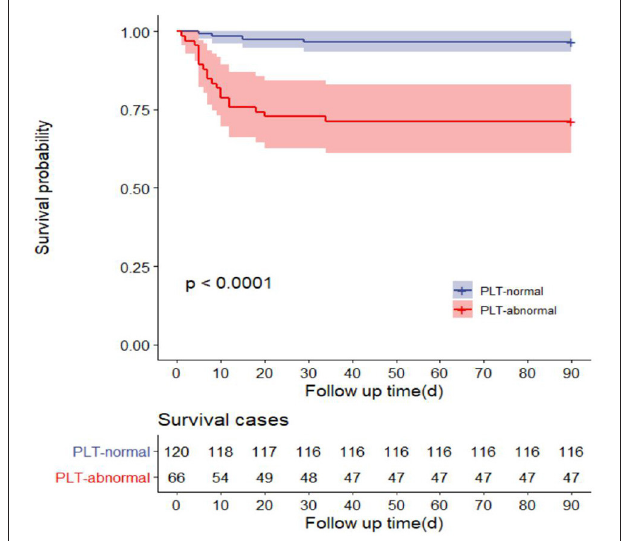
FIGURE 2 | Survival curves of 90-day mortality rate in PLT-abnormal group and PLT-normal group.